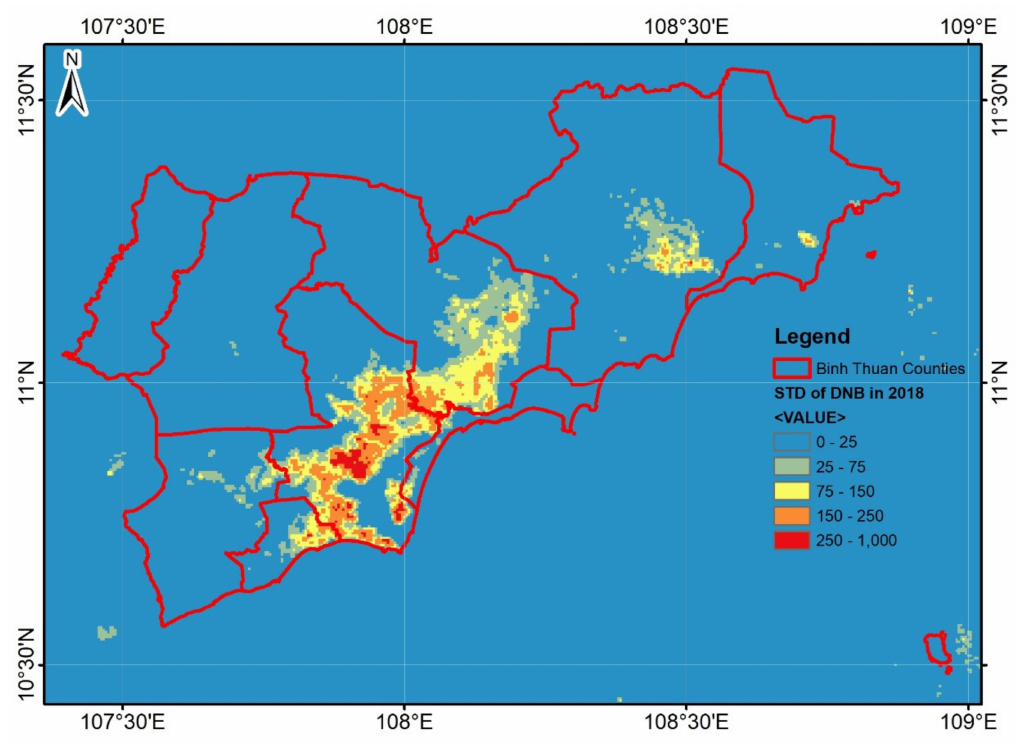
Figure 6. The temporal series changes of NTL brightness of Binh Thuan province in 2018.